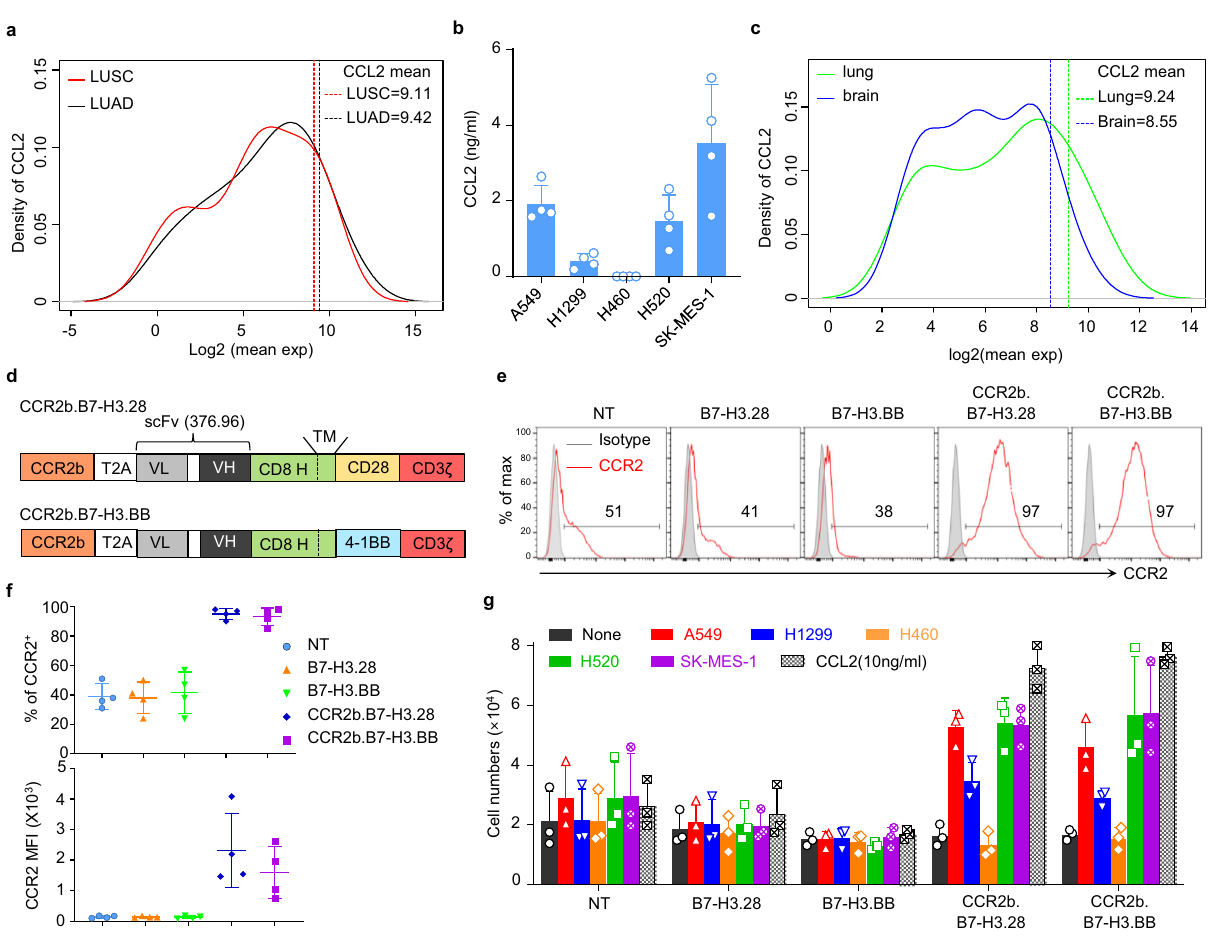
Fig. 3 Coexpression of CCR2b in B7-H3.CAR-T cells improves the migration toward CCL2. a Mean gene expression distributions of CCL and CXCL family members (41 genes) in lung cancer adenocarcinoma (LUAD) ( n = 517) and lung cancer squamous cell carcinoma (LUSC) ( n = 501) cohorts from TCGA data set. The solid curve lines indicate the distribution of the quantiles of CCL2 in all 41 chemokines genes at each expression level, and the dotted line indicates the mean expression of CCL2 in LUAD and LUSC. b CCL2 measured in the culture supernatant of NSCLC cell lines (1 × 10 5 /mL cells cultured in 24-well plates for 24 h) ( n = 4 independent samples). Data are presented as mean values + SD. c Mean gene expression distributions of CCL and CXCL family members (39 genes) from 37 NSCLC paired with brain metastasis. The solid curve lines indicate the distribution of the quantiles of CCL2 in all the 39 genes at each expression level and the dotted line indicates the mean expression of CCL2 in lung cancer and brain metastasis. CCL2 expression is in the top 15 and 8% quantiles of the 39 CCL and CXCL genes expression in primary lung cancer tissue and brain metastasis, respectively. d Schematic of the vectors encoding B7-H3.CAR and CCR2b. e Representative fl ow plots showing CCR2 expression in control non-transduced T cells (NT), B7-H3.28, B7- H3.BB, CCR2b.B7-H3.28 and CCR2b.B7-H3.BB CAR-T cells. f Summary of CCR2 expression percentage (top) and MFI (bottom) in NT, B7-H3.28, B7- H3.BB, CCR2b.B7-H3.28 and CCR2b.B7-H3.BB CAR-T cells ( n = 4 independent experiments using CAR-T cells generated from four different donors). Data are presented as mean values ± SD. g Cell numbers of NT, B7-H3.28, B7-H3.BB, CCR2b.B7-H3.28 and CCR2b.B7-H3.BB CAR-T cells migrated to the bottom of the transwell chambers with 5 μ m pores that were induced by the culture supernatant of NSCLC cell lines and human CCL2 recombinant protein (10 ng/mL), ( n = 3 independent experiments using CAR-T cells generated from three different donors). Data are presented as mean values + SD. Source data for ( b , f , g ) are provided as a Source Data fi le. Source data for ( a , c ) are provided as Supplementary Table